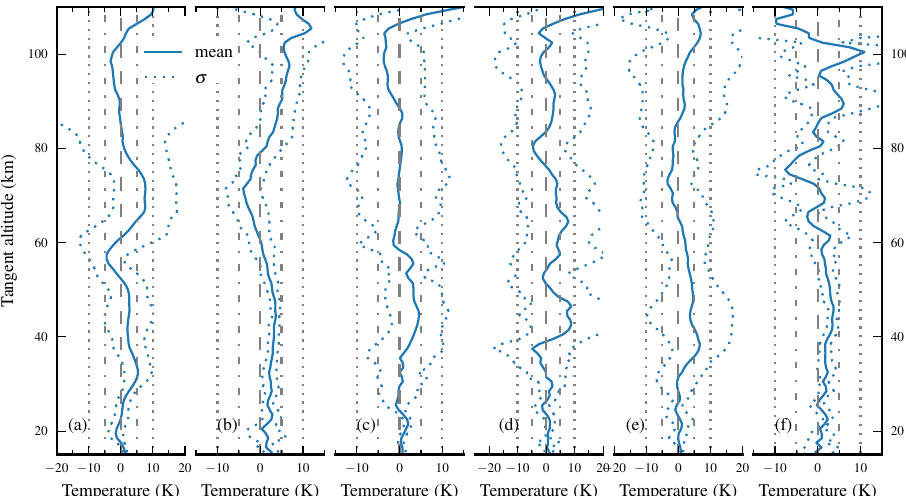
Figure 5. The mean of the differences between temperature profiles retrieved by GGG and ACE-FTS v3.5 (GGG − ACE) for each set of occultations in Table 2: (a) Arctic 2010, (b) Middle East, (c) Arctic fall, (d) Arctic winter, (e) Antarctic spring, and (f) low latitudes. Standard deviations are shown as dashed lines ( ±